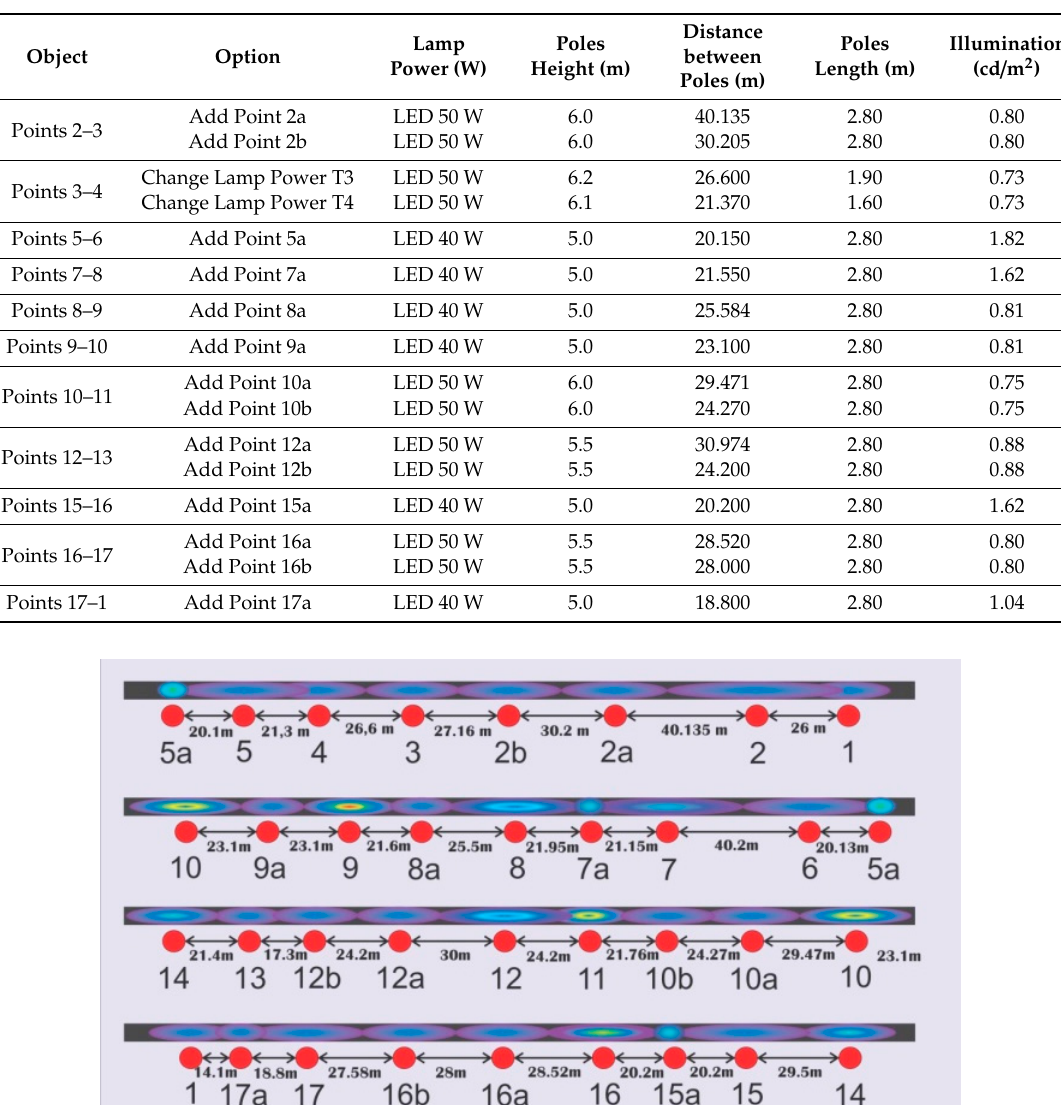
Figure 7. Illumination simulation of Alternative 1. Table 3. Simulation results of Alternative 2.